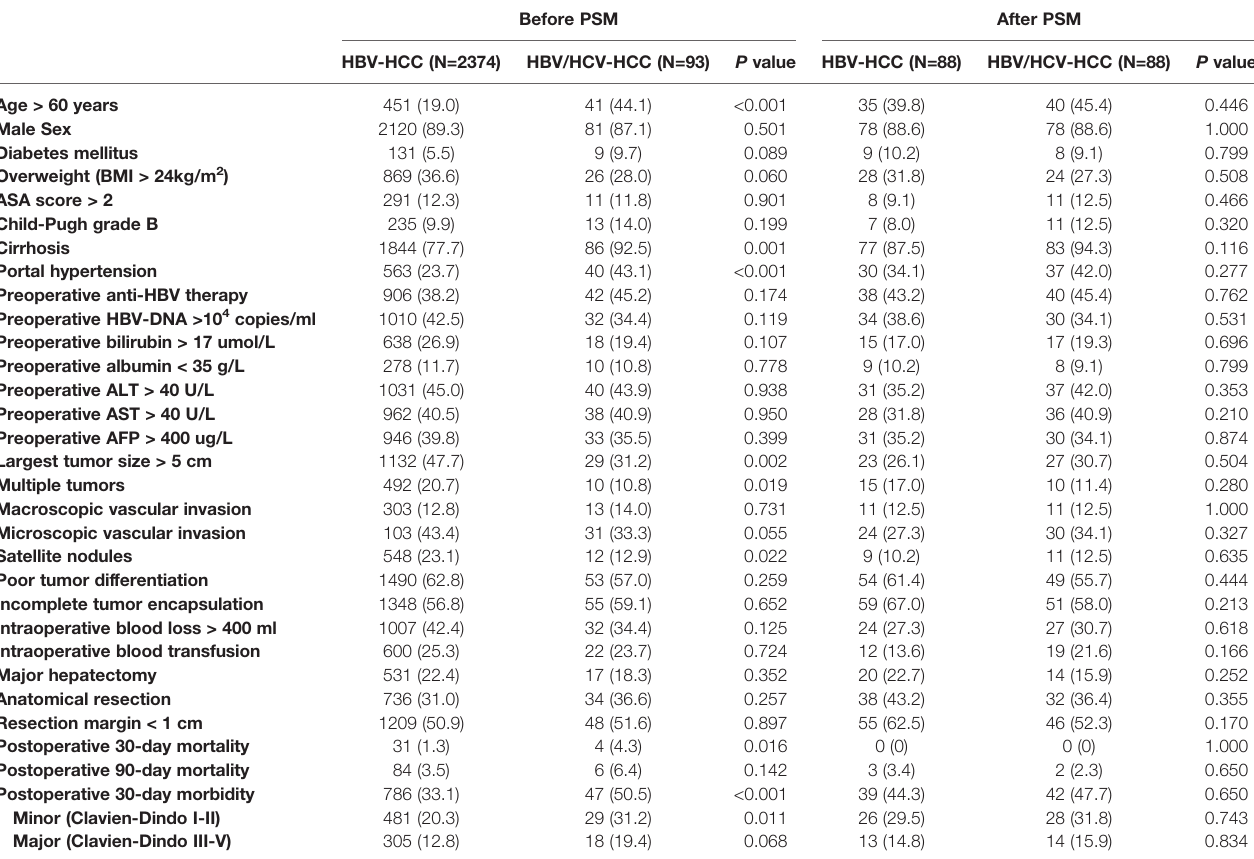
TABLE 1 | Comparisons of patients ’ clinicopathologic characteristics, operative variables, and short-term outcomes between patients with HBV/HCV-HCC and HBV- HCC before and after propensity score matching. Before PSM After PSM HBV-HCC (N=2374) HBV/HCV-HCC